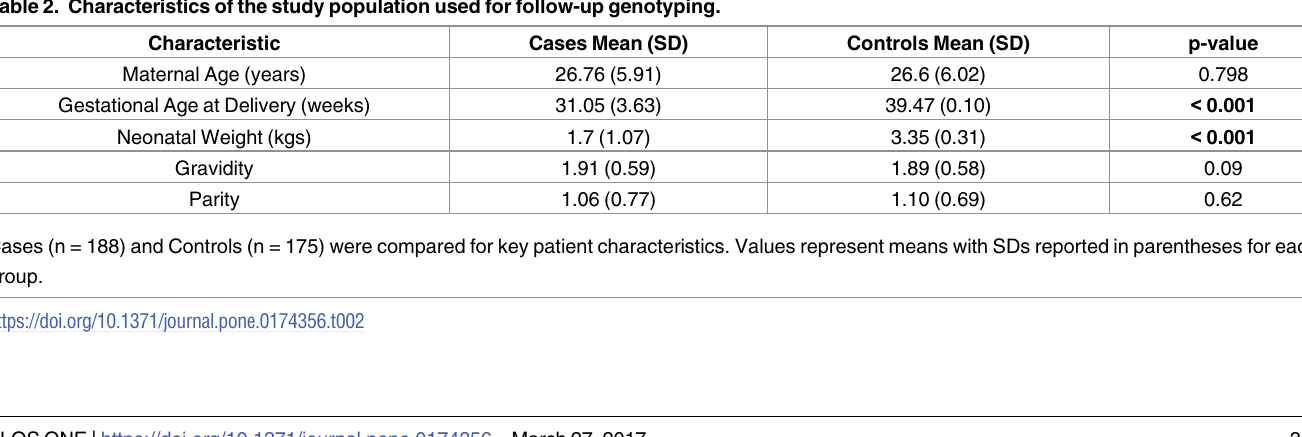
Table 2. Characteristics of the study population used for follow-up genotyping.